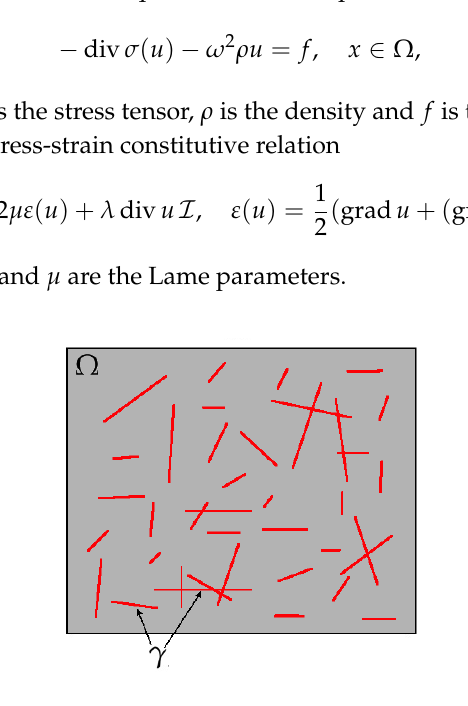
Figure 1. Illustration of the computational domain Ω (grey color) and fractures γ (red